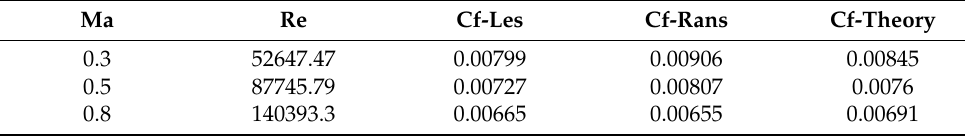
Table 2. Frictional drag coefficient of smooth